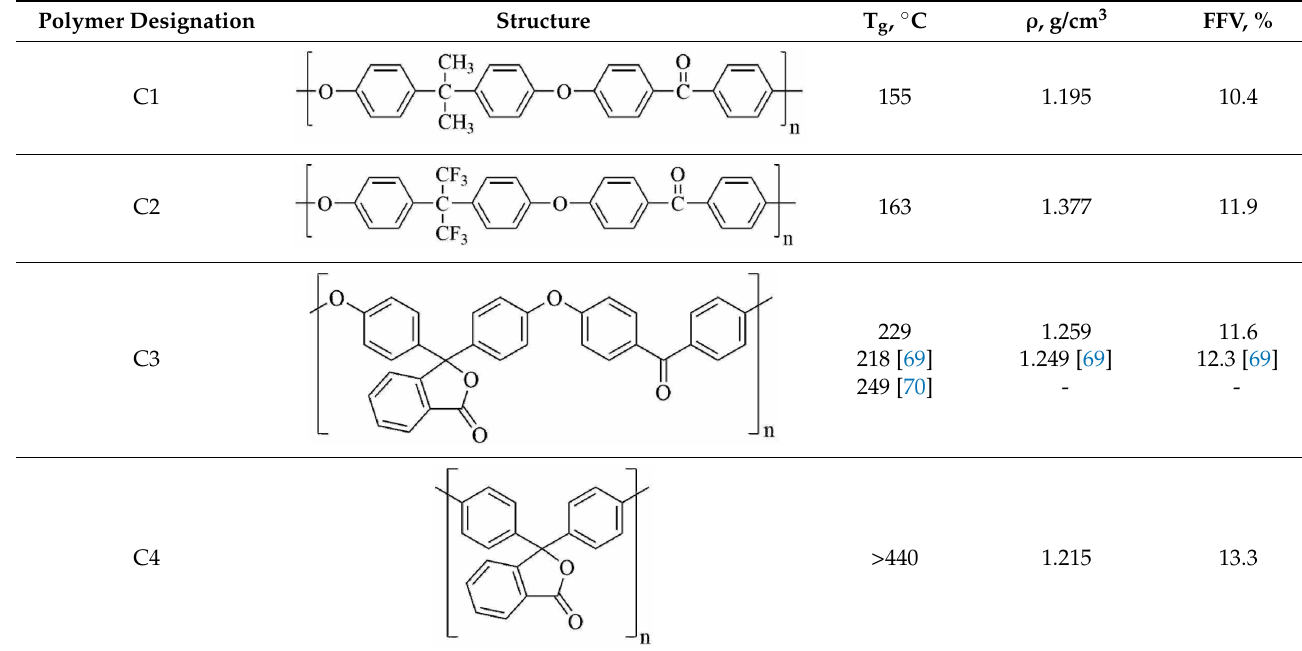
Table 2. Physicochemical properties of PAEKs.